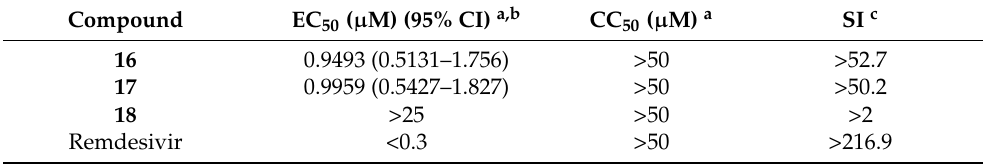
Table 2. Anti-SARS-CoV-2 activity and cytotoxicity of the tested compounds in CaCo-2 cells. Compound